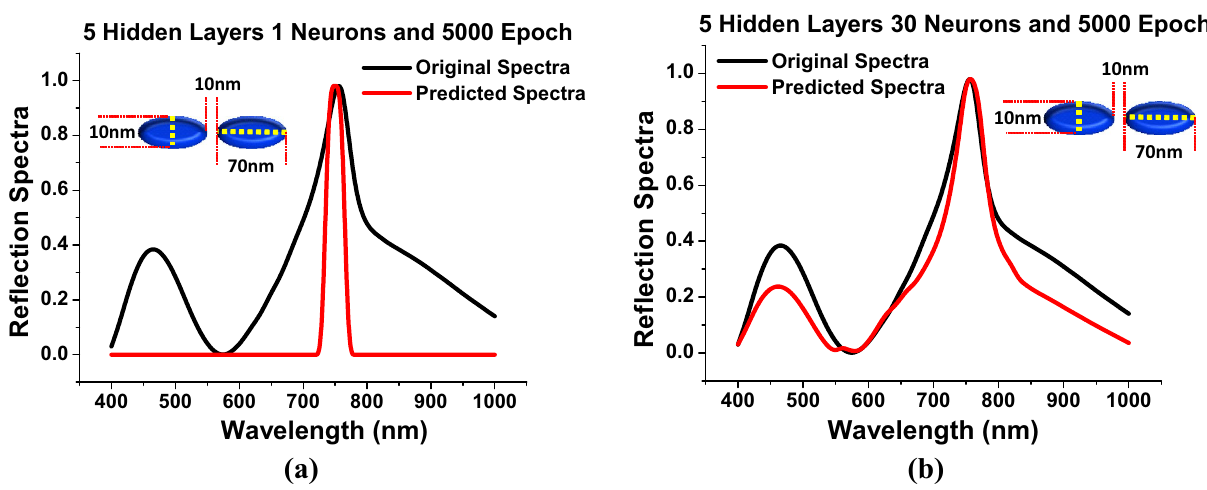
Original Spectra